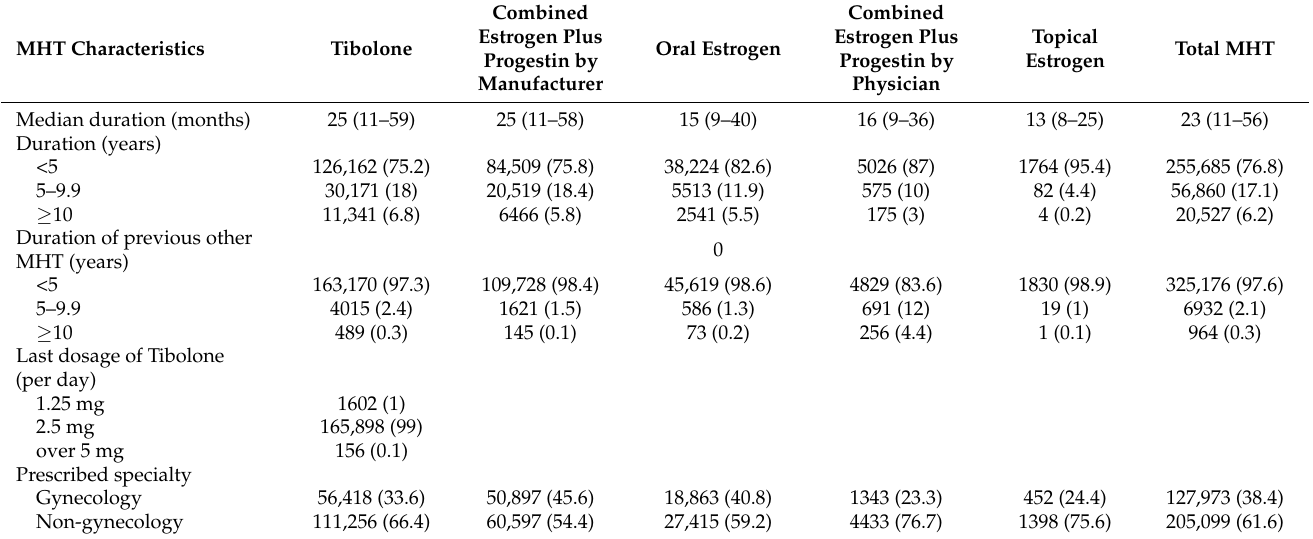
Table 2. Characteristics of women prescribed menopausal hormone therapy, Korea National Health Insurance Data, 2002–2019.